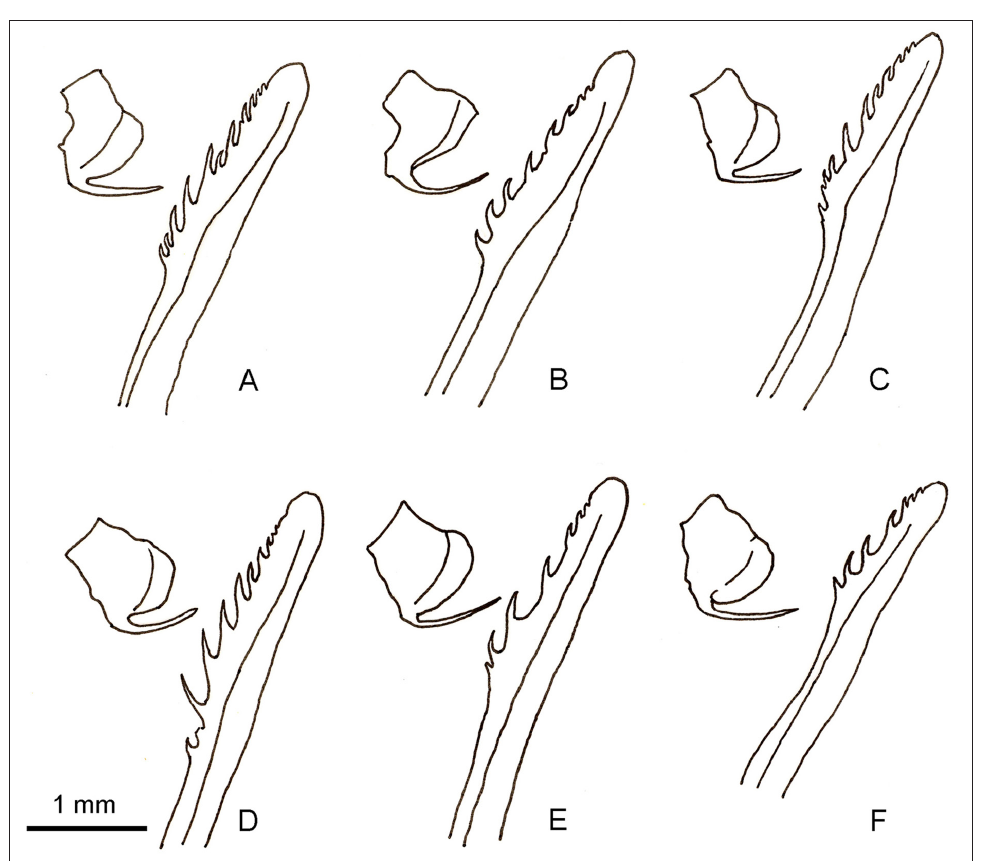
Fig. 11. Gnathos and valva extremity in various specimens of Eryphanis zolvizora inca ssp. nov. A . PT from Santo Domingo, Puno, Peru (BMNH 8223). B . PT from San Lorenzo, Cusco, Peru (MNHN, PPB 2115). C . HT from Aguas Calientes, Cusco, Peru (MJP). D . PT from Alfamayo, Cusco, Peru (MNHN, PBB 2184). E . PT from Calabaza, Junín, Peru (MNHN, PBB 2308). F . Specimen from Oxapampa, Pasco, Peru